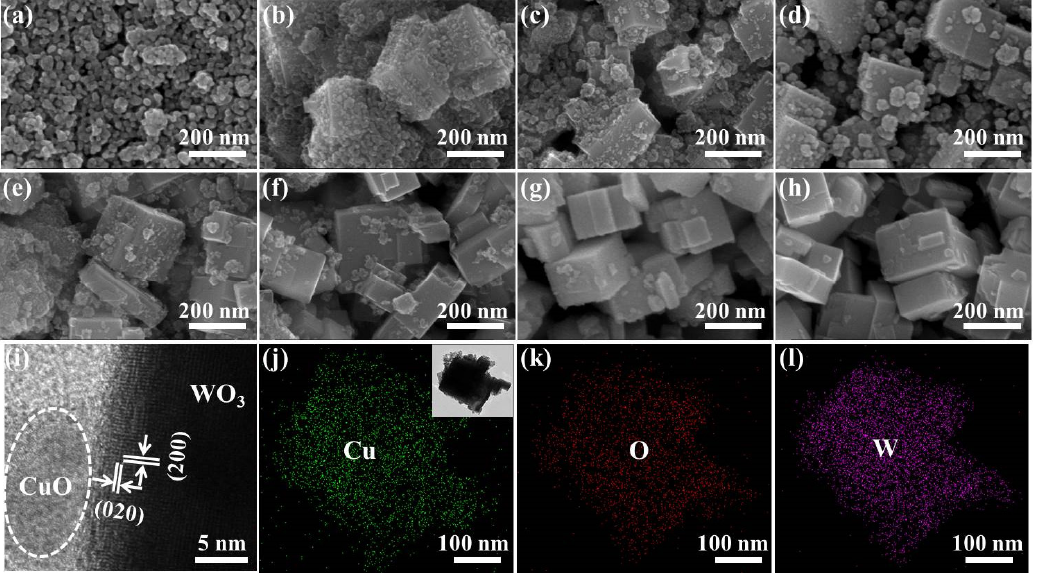
Figure 2. SEM images of the CuO/WO 3 composites with different Cu/W molar ratios: ( a ) 1:0, ( b ) 1:0.5, ( c ) 1:1, ( d ) 1:1.5, ( e ) 1:2, ( f ) 1:5, ( g ) 1:10, and ( h ) 0:1. ( i ) TEM image of the CuO/WO 3 (1:1) sample; ( j – l ) Cu, O, and W elemental mapping of the CuO/WO 3 (1:1) sample.